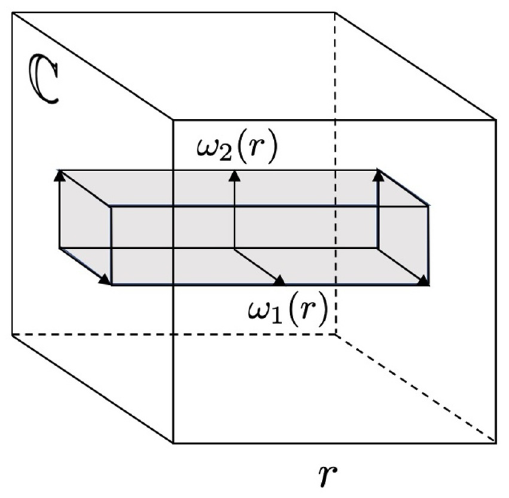
Figure 1 . Chern-Simons theory on T 2 × I is modular invariant, even when the boundary tori have different complex structures. Here r is the coordinate along the interval, and ( ω 1 ( r ) , ω 2 ( r )) are the lattice vectors corresponding to the torus as a function of r